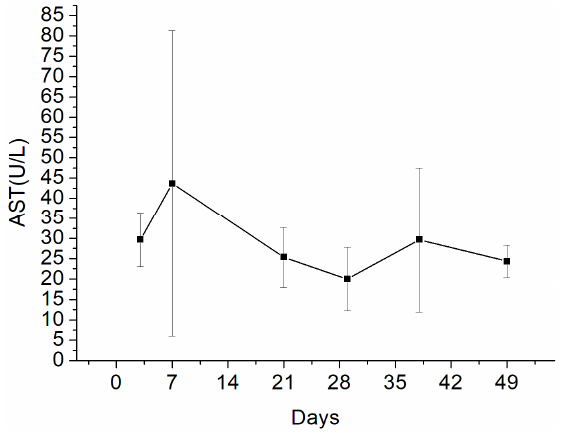
Figure 11. Estimation of blood aspartate transaminase (AST) levels.